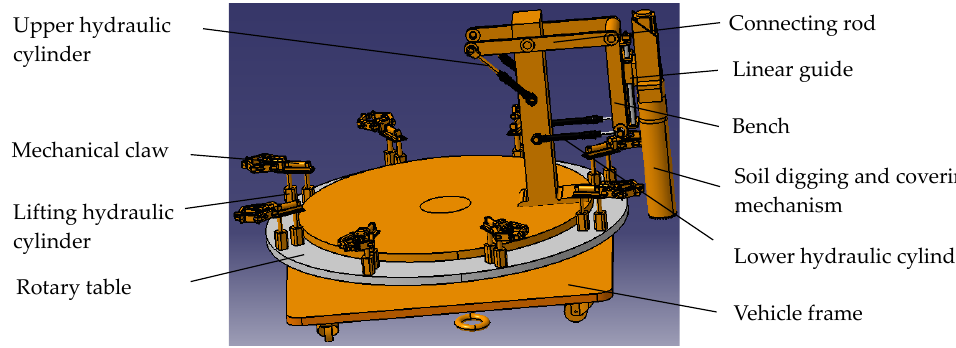
Figure 36. Improved new tree-planting machine concept structure.